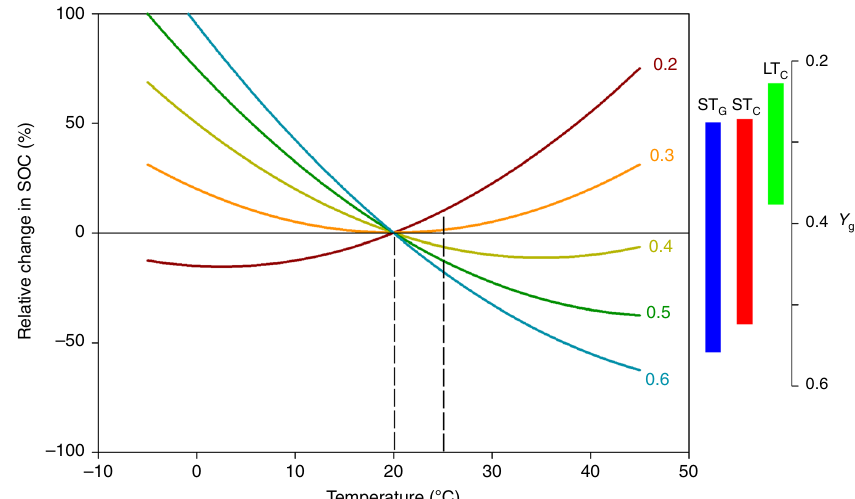
Fig. 3 Soil organic carbon change under different temperature and Y g (intrinsic microbial carbon use ef fi ciency at 20 °C). Modeled relative change (%) in steady-state soil organic carbon (SOC) as a function of temperature ( − 10 °C to 40 °C) given a certain Y g (e.g., 0.2, 0.3, 0.4, 0.5, and 0.6 represented by different colors). The dashed lines demonstrated the percentage change of SOC under 5 °C increase in temperature (i.e., 25 °C vs. 20 °C) under a given Y g . The bars represented the 95% con fi dence interval of Y g based on short-term glucose (ST G , blue), short-term cellulose (ST C , red), and long-term cellulose (LT C , green) dataset. Parameters except Y g used model default